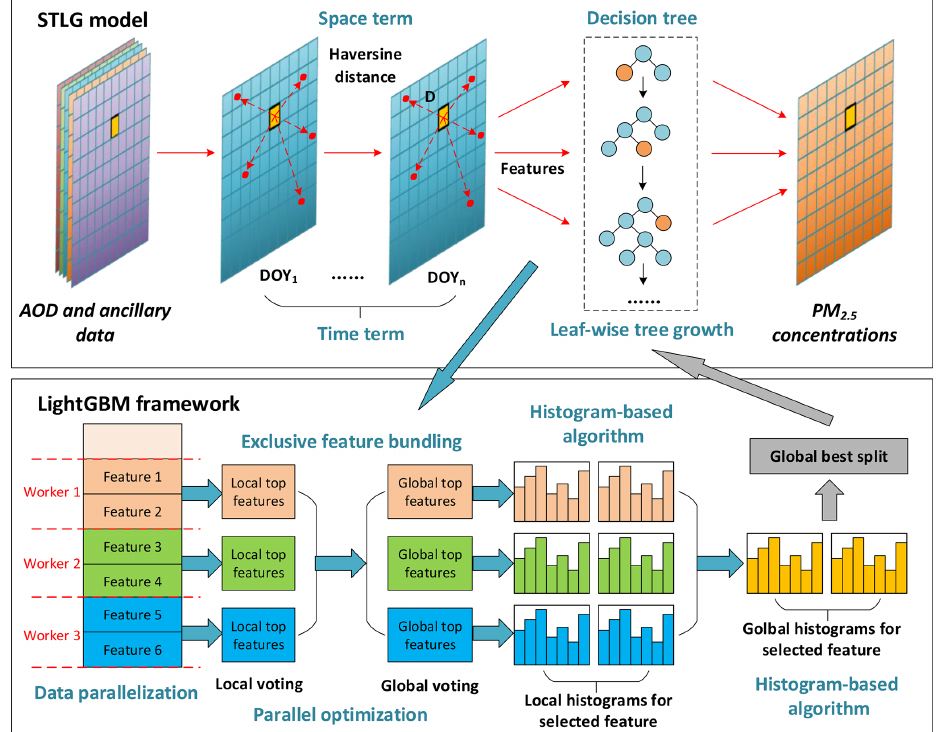
Figure 1. Schematics of the space-time LightGBM (STLG) model developed in this study (upper panel) and the framework of the original LightGBM model (bottom panel).